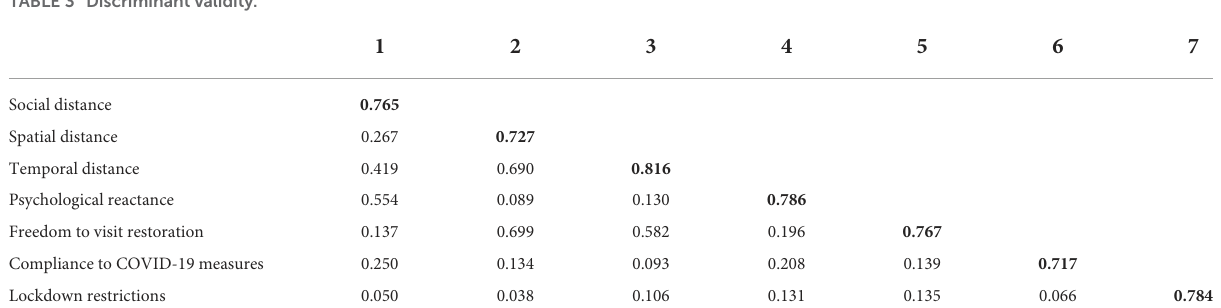
TABLE 3 Discriminant validity.